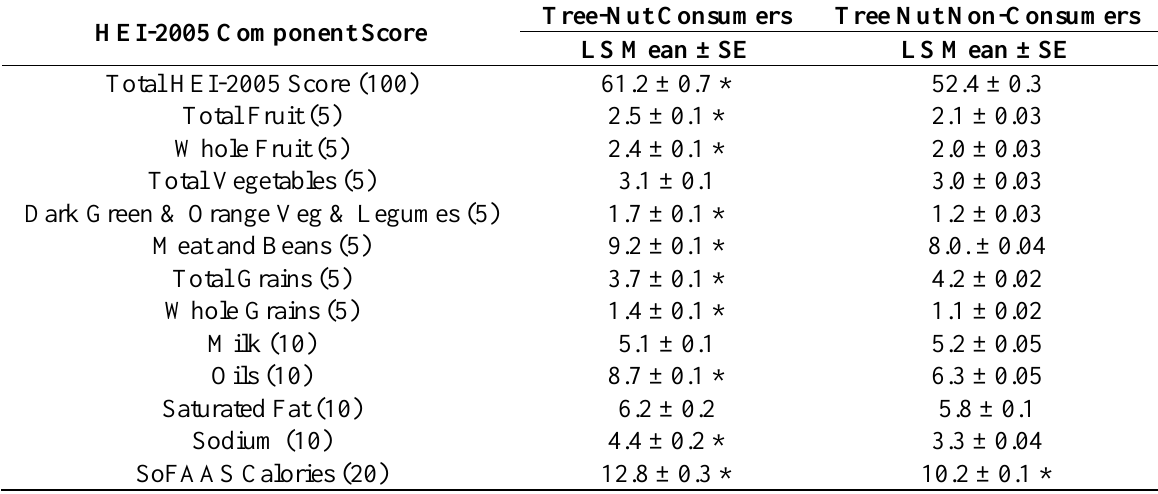
Table 4. Least-square means of Healthy Eating Index-2005 (HEI-2005) component scores by consumption of tree nuts in adults 19+ years of